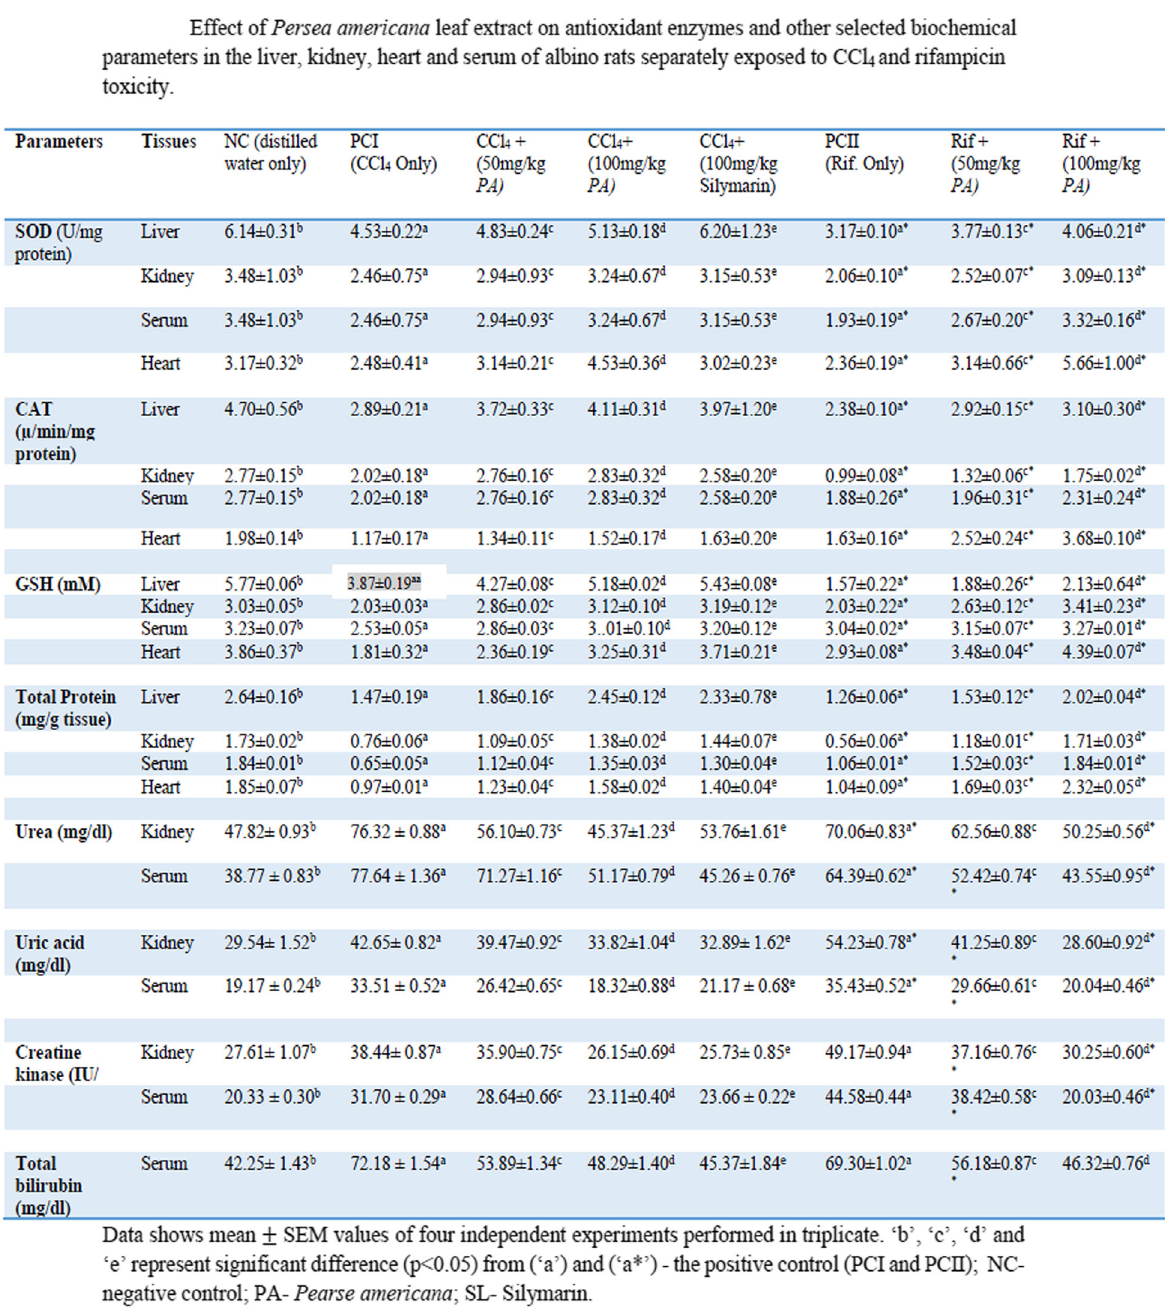
kidney, heart and serum of albino rats separately exposed to CCl 4 and rifampicin